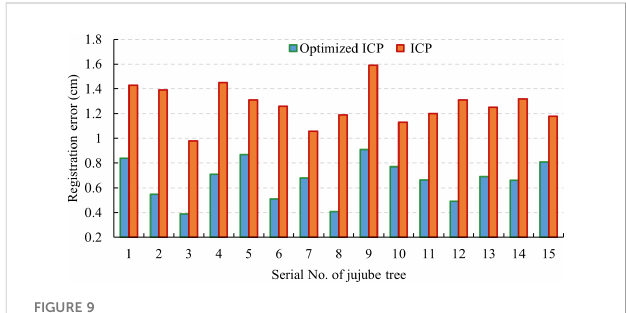
FIGURE 7 Identi fi cation results of pruning points (pink dots) on primary branches.